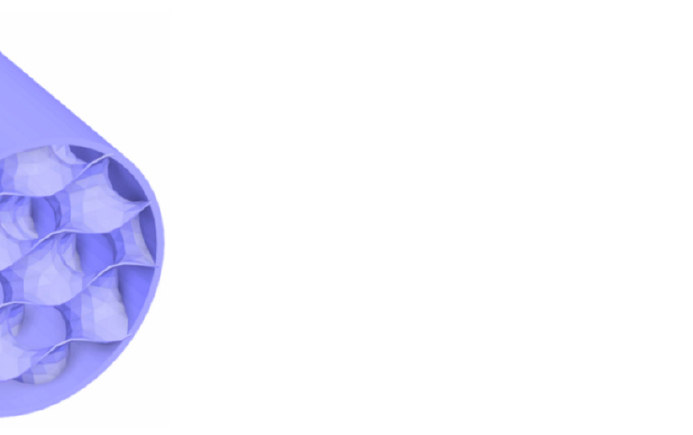
Figure 7. View of the gyroid structure made using the AM method for the study of heat transfer under forced convection conditions [120].